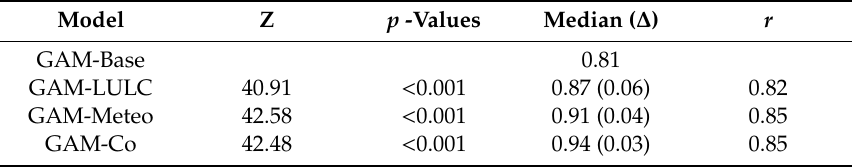
Table A6. Wilcoxon signed rank tests for SpCV-Comparison.